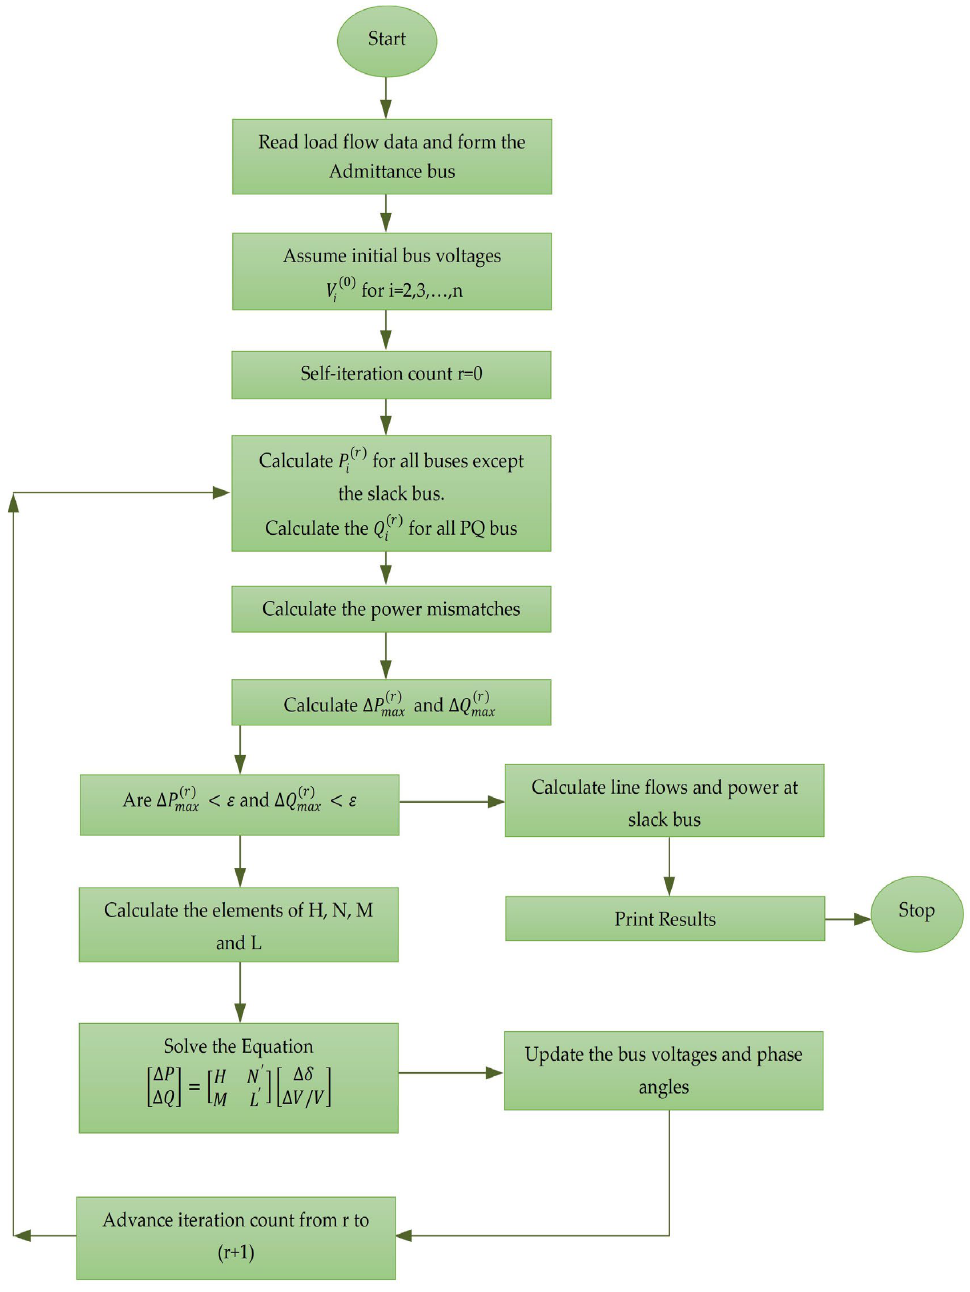
Figure 6. Flow chart of the Newton-Raphson method .